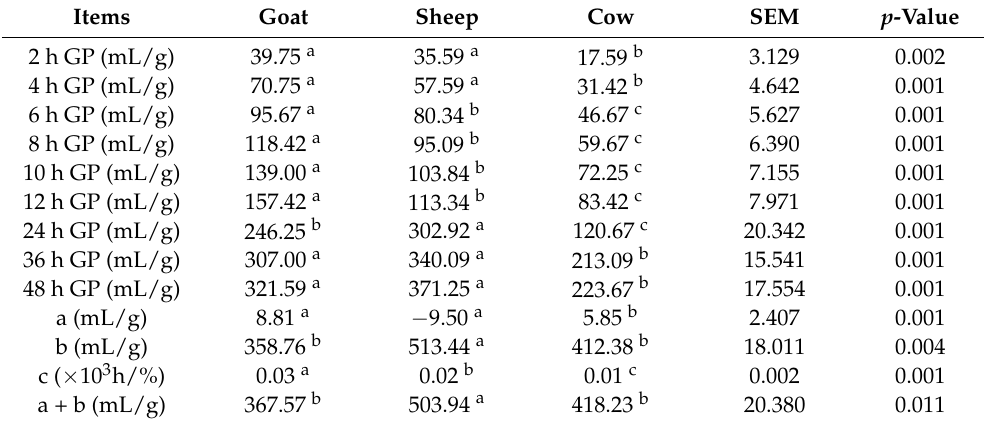
Table 2. Ruminal cumulative GP and GP parameters (mL/g DM) of the goat, sheep, and cow. Items Goat Sheep